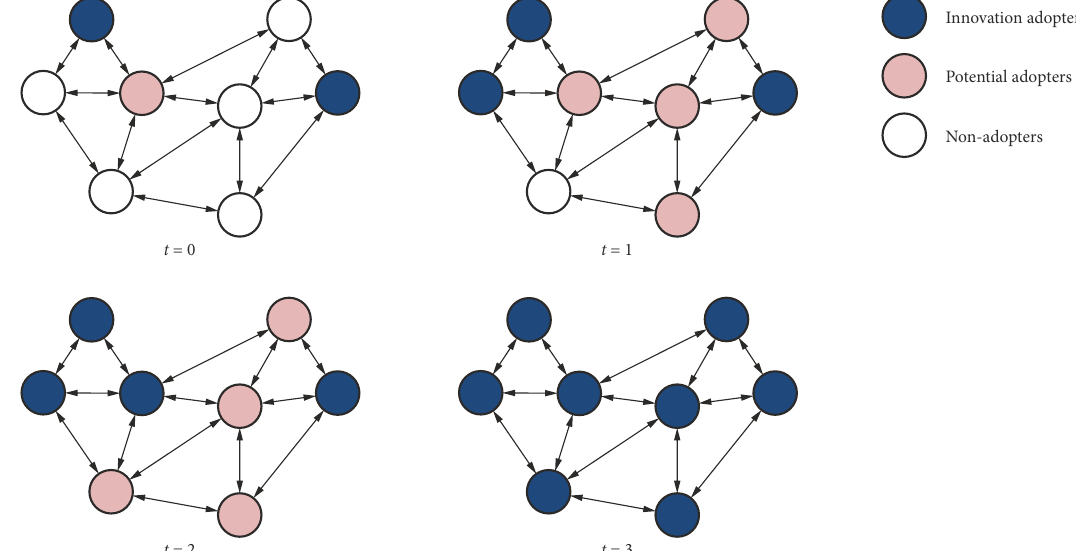
Figure 3. Cascade processes of collaborative